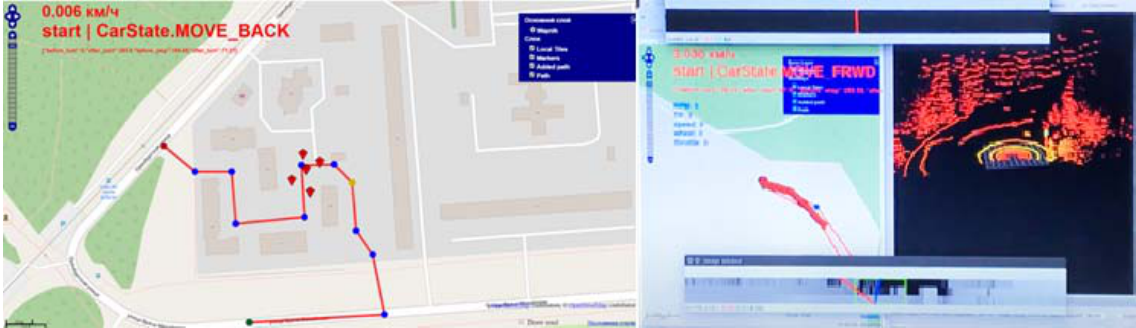
Figure 4. Mapping tool and car state visualization.